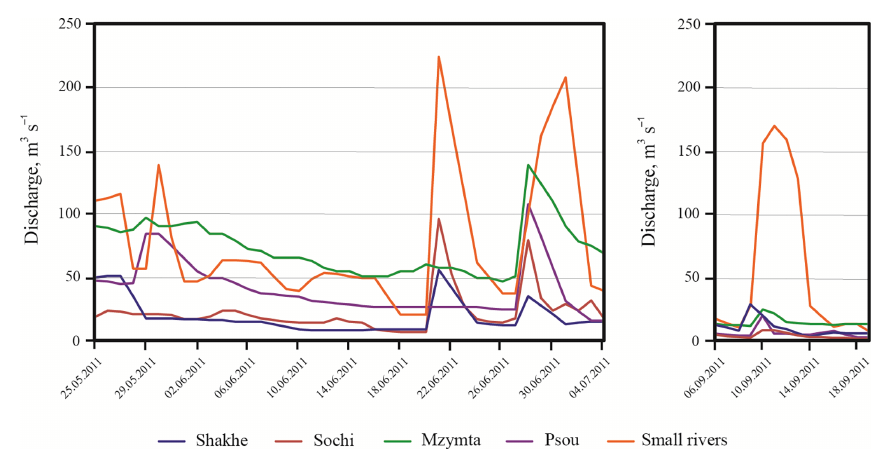
Figure 4. Daily discharge rates of the rivers of RCBS during 25 May to 4 July 2011 (left) and 6–19 September 2011 (right), measured at the gauge stations (for the Mzymta and Sochi rivers) and reconstructed using satellite imagery and numerical modeling (for the Shakhe, Psou, and small rivers).